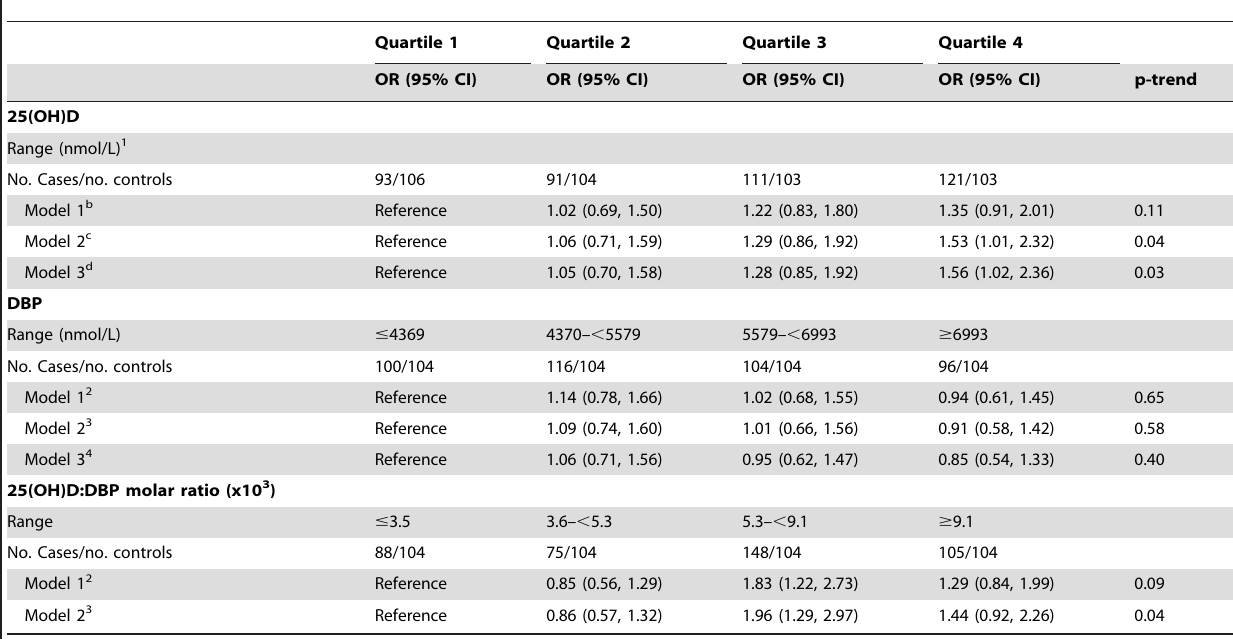
Table 2. Association between serum 25(OH)D, DBP, and the 25(OH)D:DBP molar ratio, and the risk of colorectal cancer, ATBC